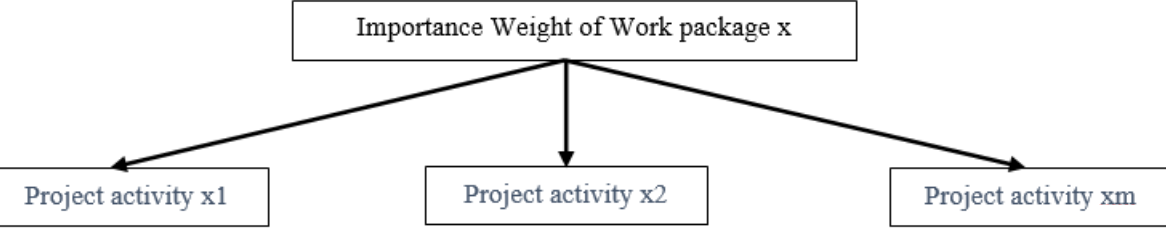
Figure 5. Weight distribution of work package on work package